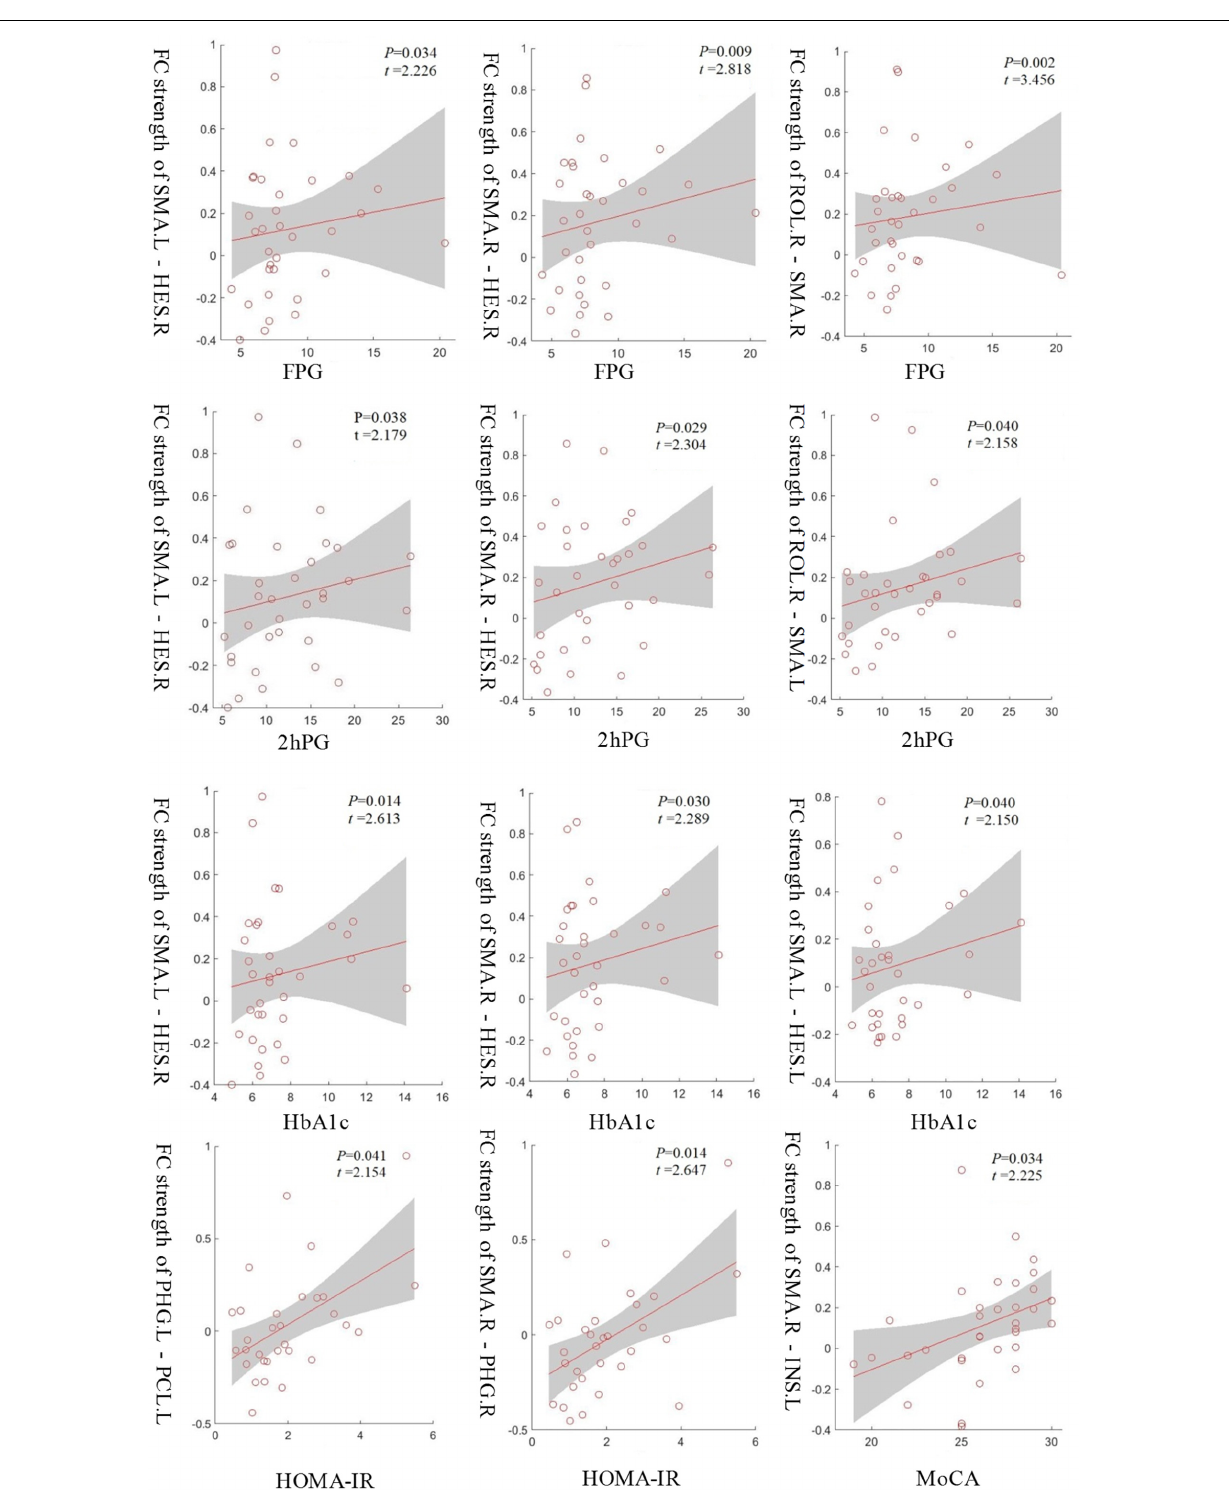
FIGURE 4 | The functional connectivity strengths of the SMA.L - HES.R, SMA.R - HES.R and ROL.R - SMA.R in the T2D group were positively correlated with FPG and the strengths of the SMA.L - HES.R, SMA.R - HES.R and ROL.R - SMA.L were positively correlated with 2hPG. Significant positive correlations were also observed between the connectivity strengths of the SMA.L - HES.R, SMA.R - HES.R and SMA.L - HES.L and HbA1c and between the strengths of the PHG.L - PCL.L and SMA.R - PHG.R and HOMA-IR. Moreover, the connectivity strengths of the SMA.R - INS.L showed a significantly positive correlation with MoCA scores. p < 0.05,